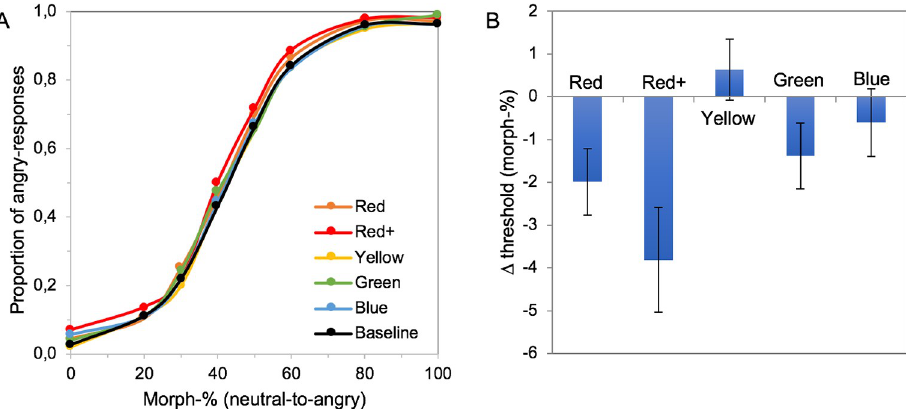
Fig 4. The effect of facial color on anger perception. (A) Psychometric functions showing anger recognition performance as a function of morph level for each facial color condition, averaged across participants (N = 20). (B) Average color-induced change in the 50% threshold (i.e. chromatic—baseline threshold) for each facial color. Error bars represent +/- 1 standard error of the mean across 20 participants.